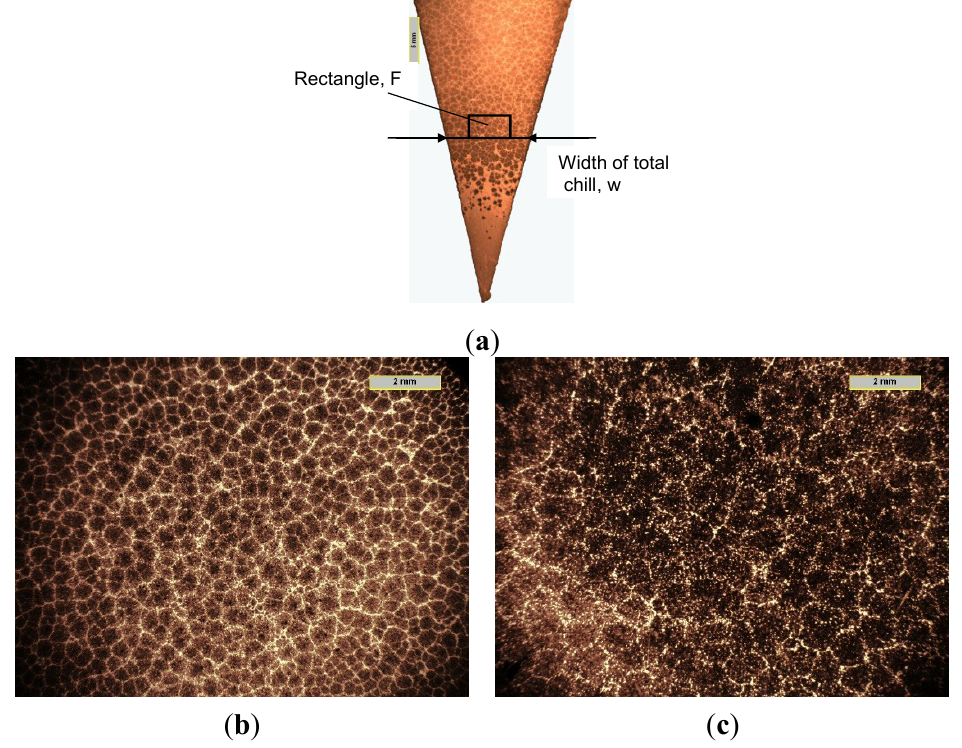
Figure 7. ( a ) Eutectic cells in a wedge-shaped casting; ( b ) bar  18 mm and ( c ) bar  28